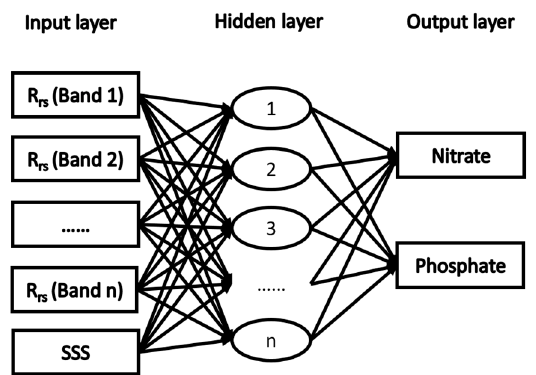
Figure 3. The three-layer neural network used in this study. In this study, the nitrate and phosphate networks were trained separately using in situ data.